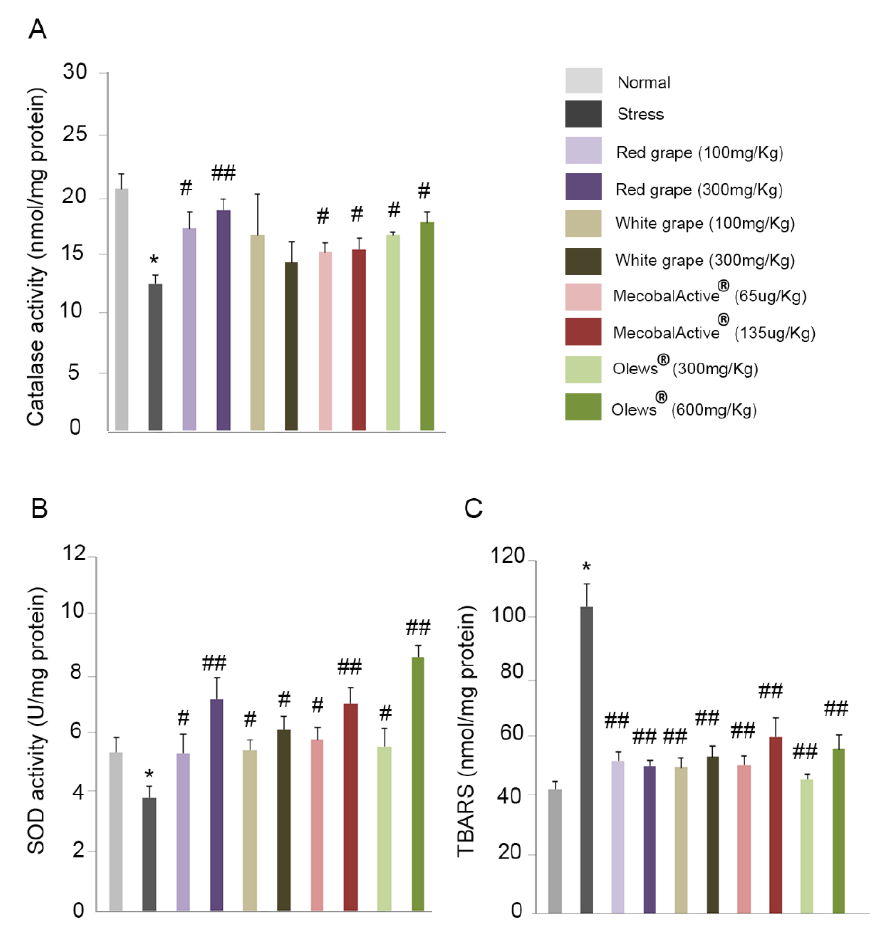
Figure 7. Natural extracts increase the activity of antioxidant enzymes. Mouse brains were isolated, and the catalase activity ( A ), SOD activity ( B ), and TBARS ( C ) were analyzed. The values are presented as mean ± SEM from eight experimental animals. One-way ANOVA and Dunnett’s multiple comparison post-hoc test were used for statistical analysis. * p < 0.05 versus normal mice, and # p < 0.05 and ## p < 0.01 versus restrained (stress) mice. Abbreviations: SOD: superoxide dismutase; TBARS: thiobarbituric acid reactive substances.